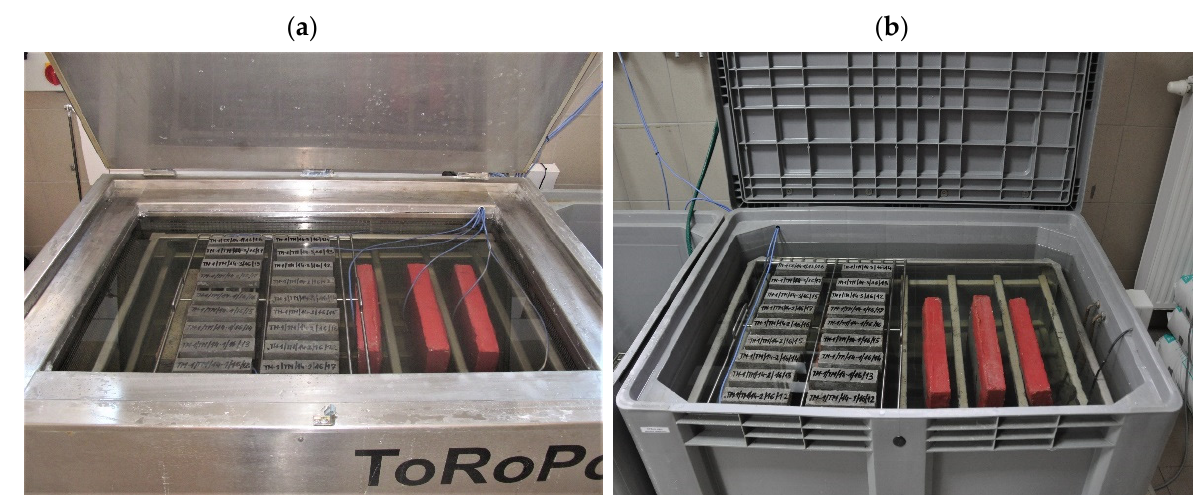
Figure 3. Set of chambers according to [4] ( a ) chamber for testing the freezing of samples in saturated salt solution; ( b ) chamber for testing the thawing of samples in water.